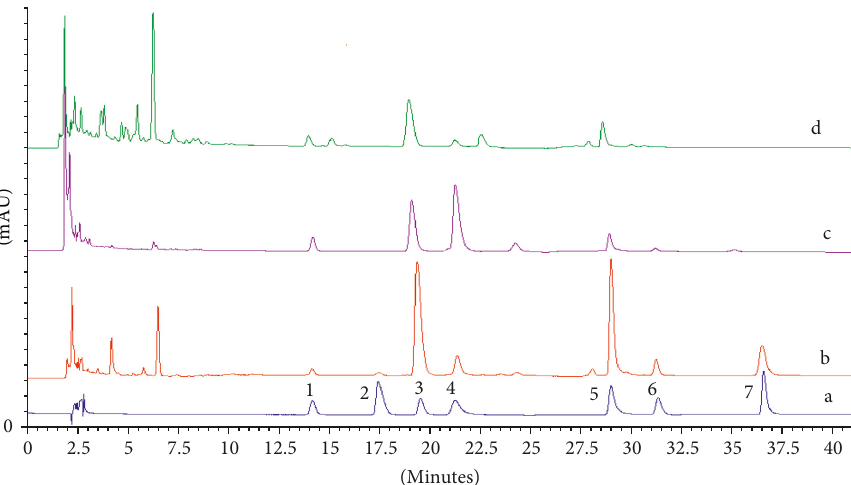
Figure 4: Example of an HPLC-DAD chromatogram of extracts from different parts of C. majus : (b) roots, (c) fruits, and (d) herbs and (a) standards of investigated alkaloids: (1) protopine, (2) allocryptopine, (3) chelidonine, (4) coptisine, (5) sanguinarine, (6) berberine, and (7)